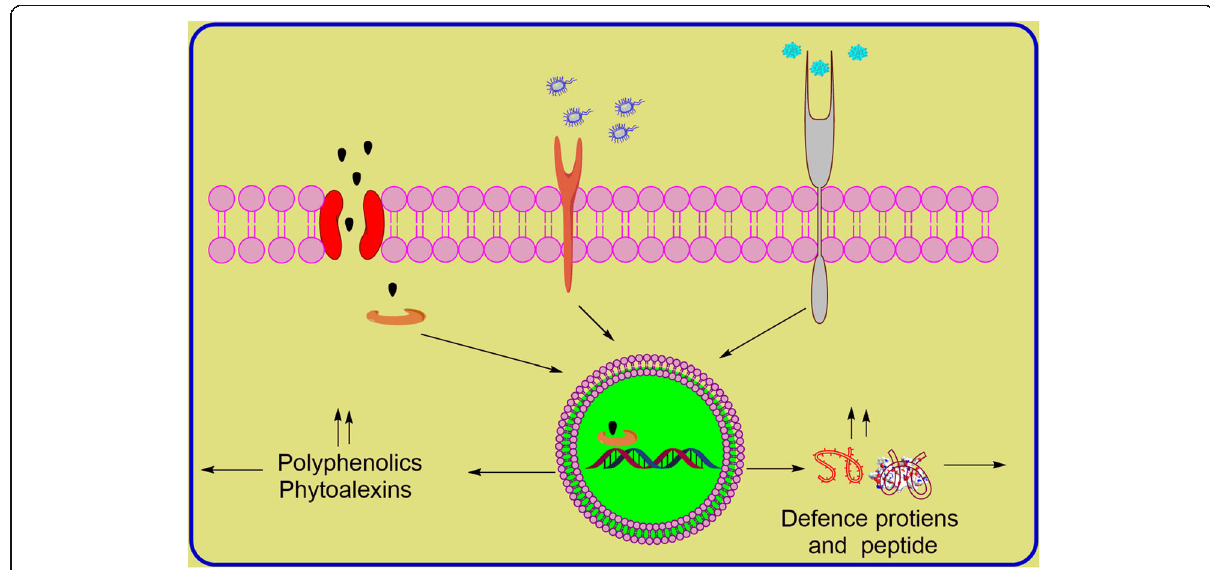
Fig. 1 Schematic representation of constitutively expressing and releasing of various defense molecules and overexpression on biotic and abiotic